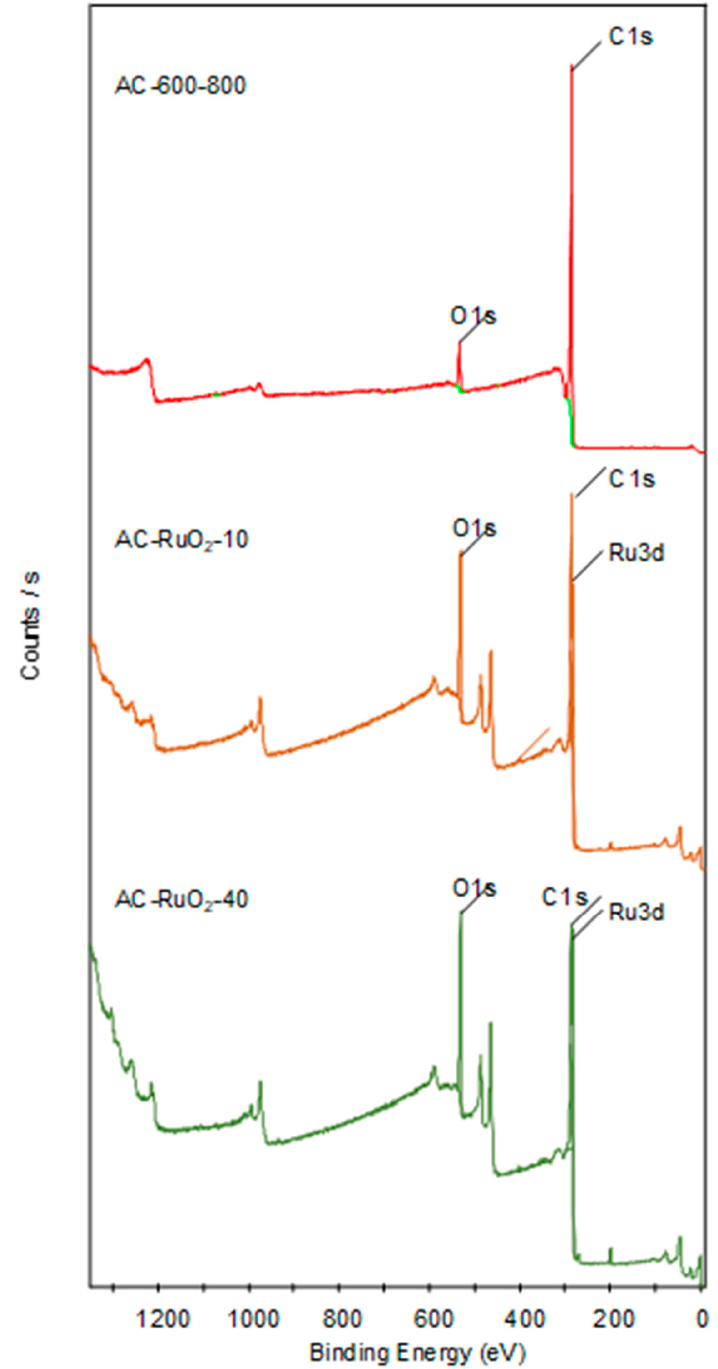
Figure 8. XPS survey spectra of sample AC-600-800, AC-RuO2-10, and AC-RuO2-40, respectively.